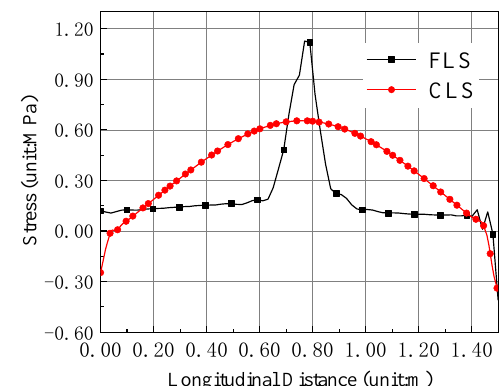
Figure 9. Stress distribution on the link-slab under highway class I load.